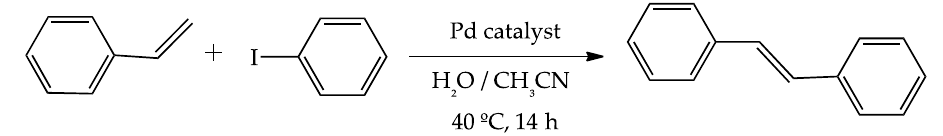
Figure 4. Yields obtained for Sonogashira and Heck C-C couplings catalyzed by Pd-scorpionates formed in situ. In all Heck experiments, the selectivity for trans -stilbene was 100% (the only product detected). The mirror of palladium(0) observed on the glassware when using the Pd-( 1 ) catalyst was probably the reason for such a low catalytic activity. This work revealed that the anchorage of a tris(pyrazolyl)methane derivative on a dendritic surface is feasible and generates an important support for further studies in supramolecular and coordination chemistry, and in catalysis. In fact, it allowed to extend the scope of C-C bonds formation catalyzed [54,55] by tris(pyrazolyl)methane type metal catalysts. The obtained results show that the synthetic process requires further investigation to ease the preparation of intermediates and improve yields. 3. Materials and Methods All syntheses were carried out under an atmosphere of dinitrogen or Argon, using standard Schlenk techniques. All solvents were dried, degassed and distilled prior to use. The reagents (Aldrich and Acros) were purchased and used without further purification. Where indicated, the reagents were synthesized in accordance with literature methods. C, H and N analyses were carried out by the Microanalytical Service of the Instituto Superior Técnico. Infrared spectra (4000 − 400 cm − 1 ) were recorded on a BIO-RAD FTS 3000MX instrument (Hercules, CA, USA) in KBr pellets and far infrared spectra (400–200 cm − 1 ) were recorded on a Vertex 70 spectrophotometer, in polyethylene and cesium iodide pellets. Vibrational frequencies are expressed in cm − 1 ; abbreviations (intensity, shape): s, m and w, strong, medium and weak; s and br, sharp and broad. Ultra-violet, visible and near infra-red (UV/vis/NIR) spectra (1600–200 nm) were recorded on a Shimadzu UV-3101PC UV-VIS NIR spectrophotometer (Duisburg, F.R., Germany). 1 H- , 13 C- and 31 P-NMR spectra were recorded with a Bruker AC 200, ARX 250, AV 300, DPX 300, AMX